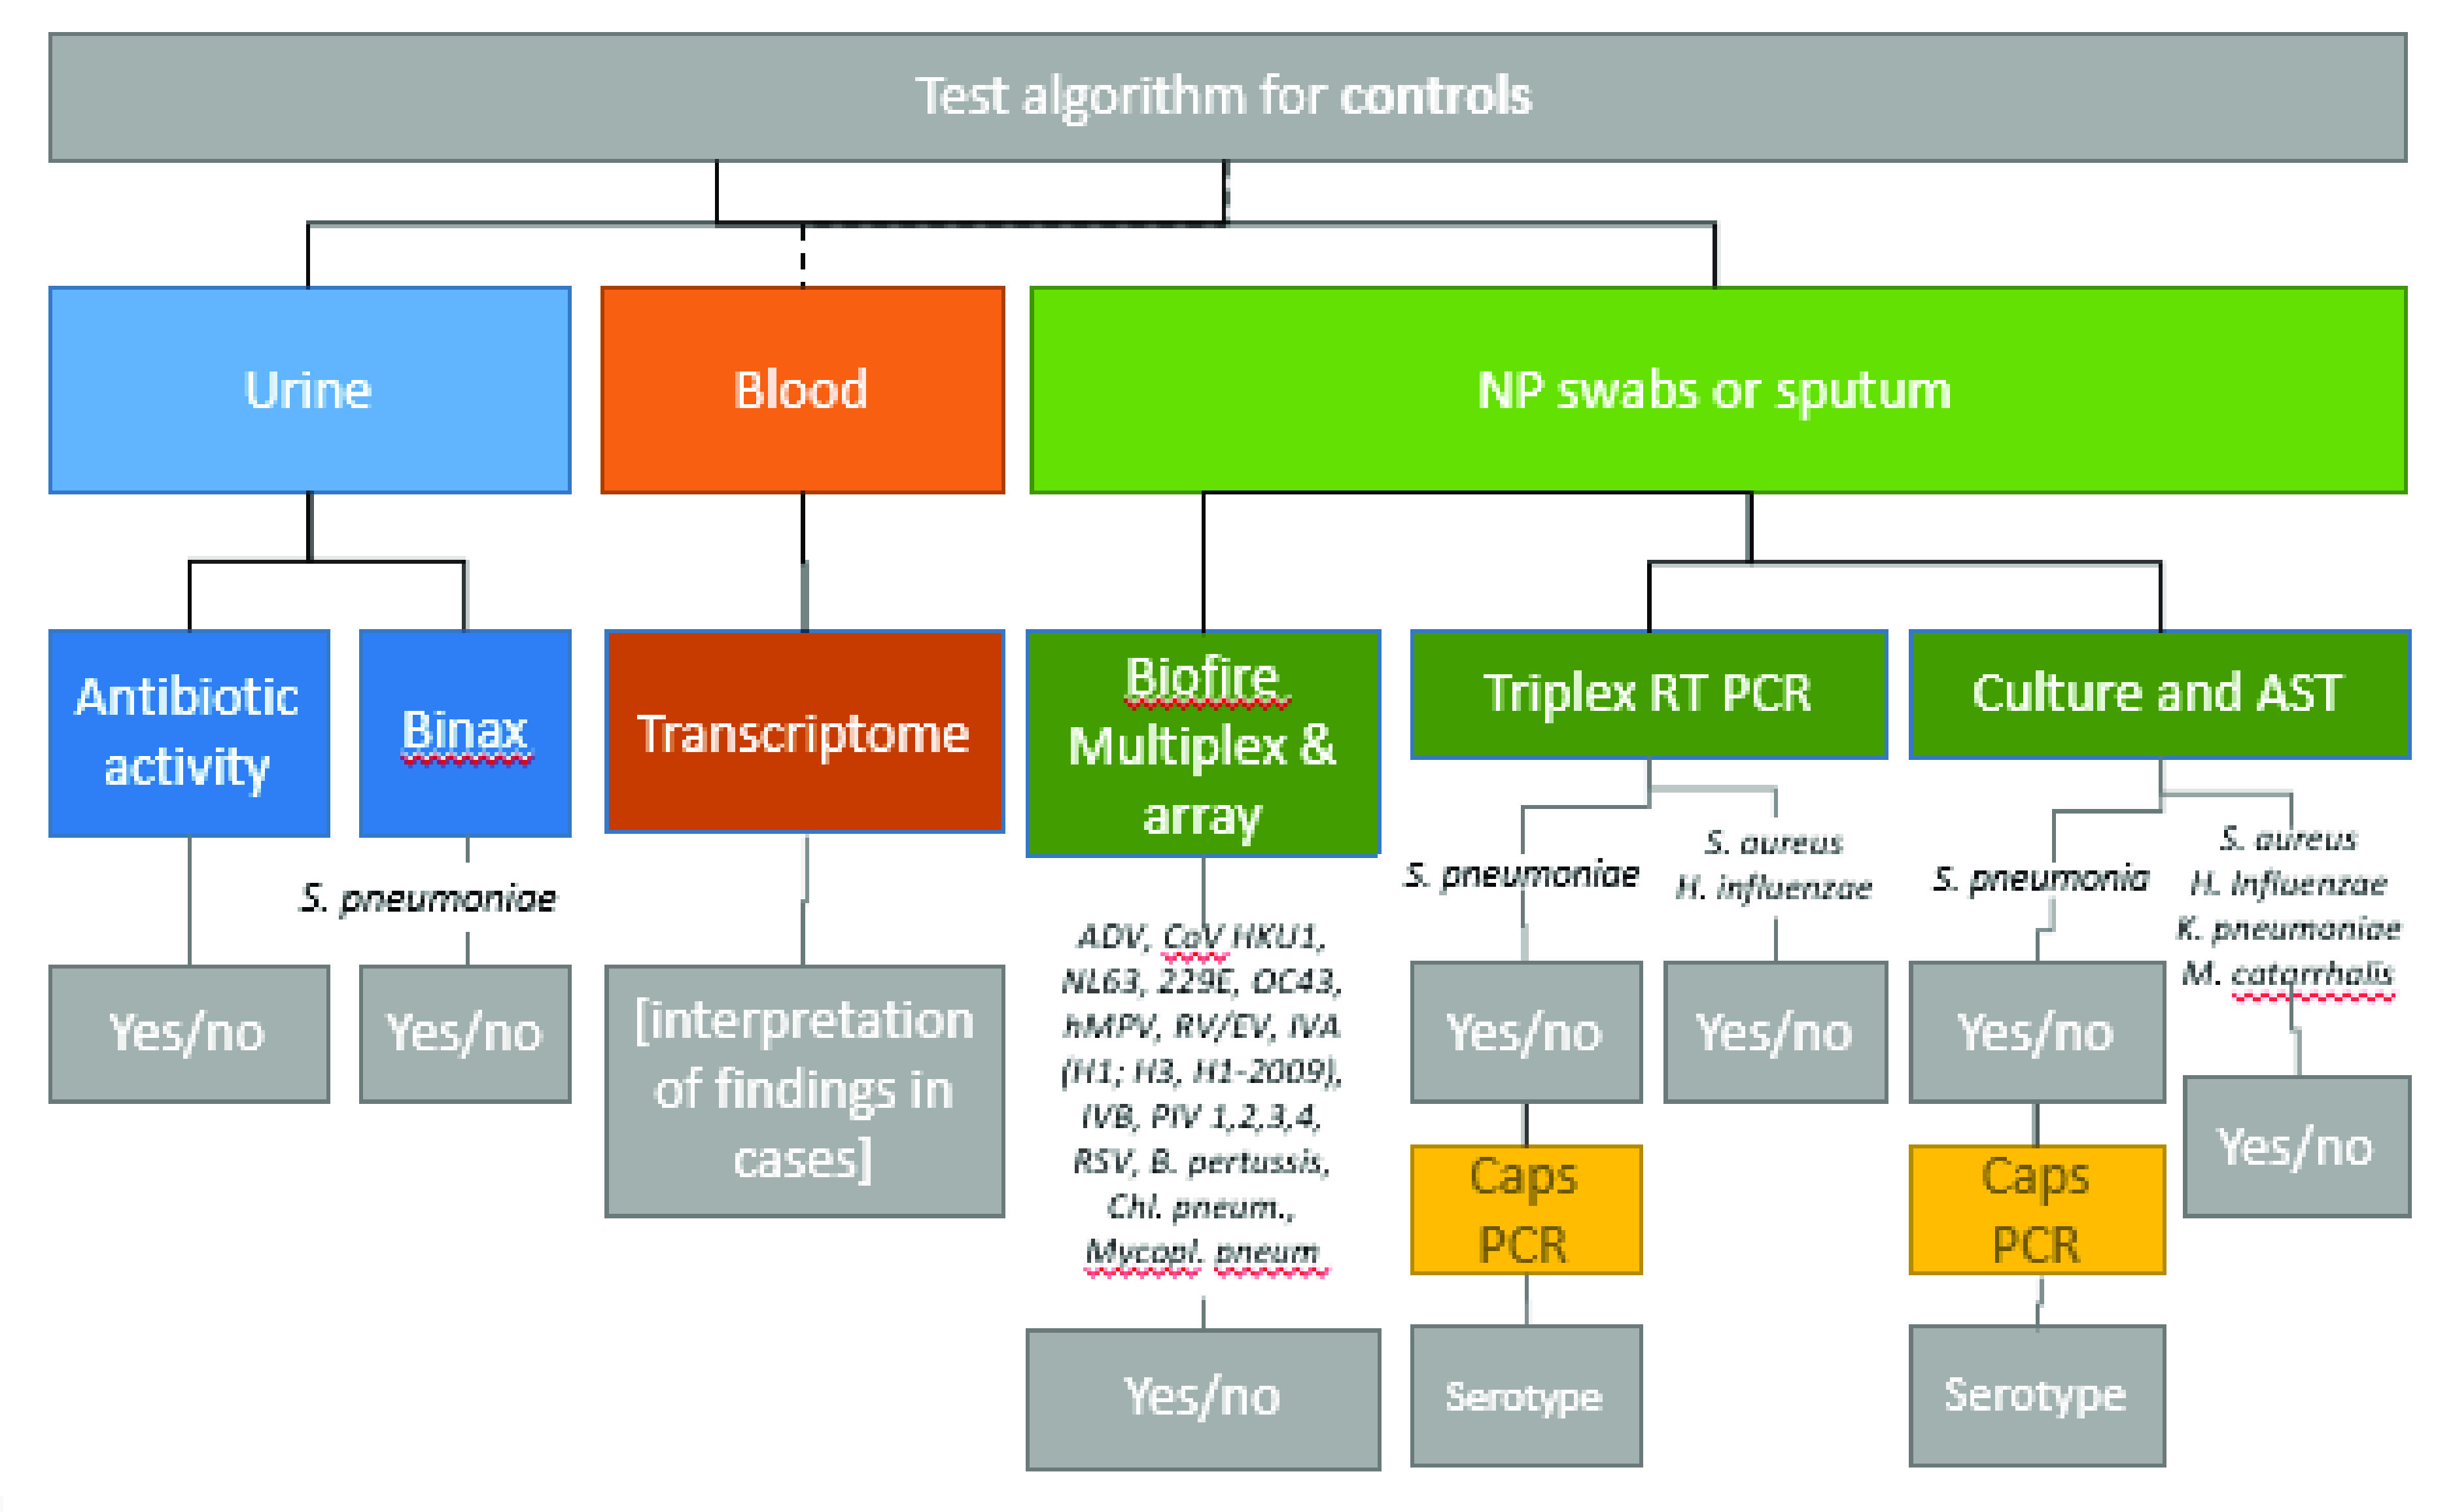
Sample analysis for controls.NP, nasopharyngeal; AST, Antimicrobial Susceptibility Testing; Caps PCR, capsular antigen serotyping PCR.